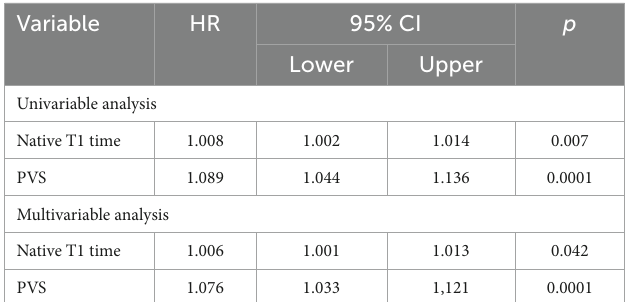
TABLE 5 Cox regression analysis for the secondary endpoint all-cause mortality.